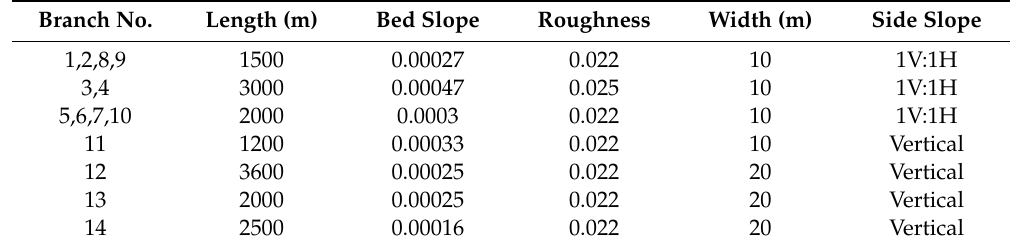
Figure 6. Loop network with dendritic branches used by Islam in 2005. Table 2. Loop network 2 parameters.